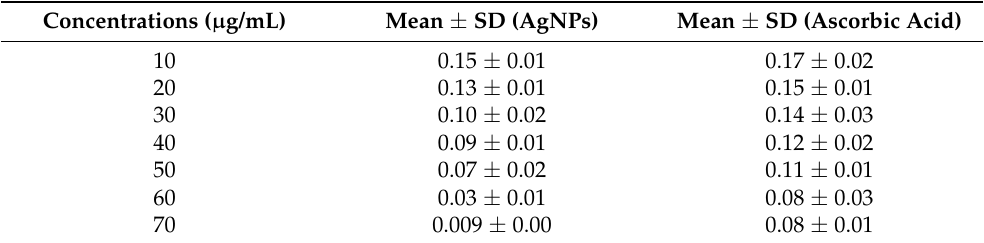
Figure 7. Antioxidant activity in a dose-dependent manner of biosynthesized BP-AgNPs from Brachychiton populneus leaf extract. Ascorbic acid is treated as a positive control. Experiments performed in triplicates and using one-way ANOVA indicate that all values are significant ( p < 0.05). Table 2. Values represented in (Mean ± SD) and significant level ( p < 0.05), through one-way ANOVA of DPPH assay.